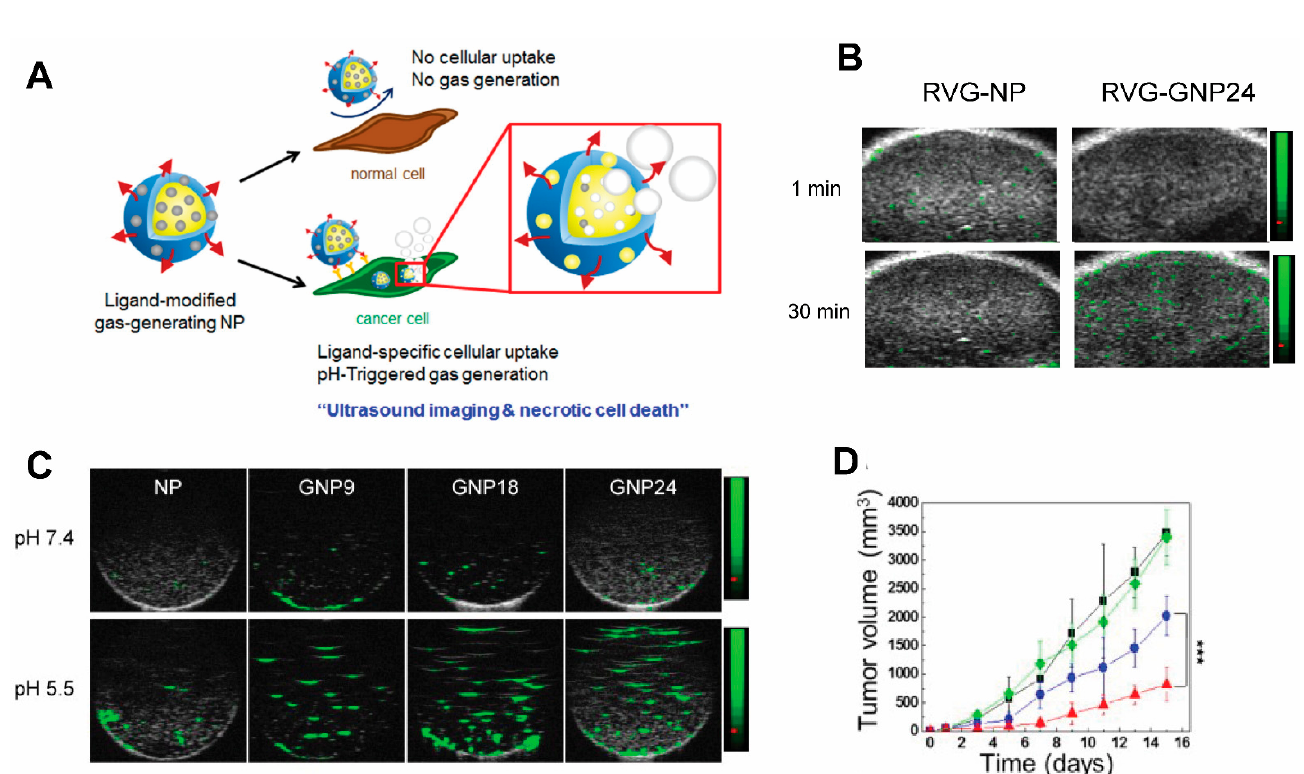
Figure 5. A targeted gas-generating nanotheranostic particle for ultrasound-guided treatment of neuroblastoma. ( A ) Schematic illustration of ligand-modified gas-generating nanoparticles for cancer-specific cellular uptake and pH-triggered gas generation. PLG nanoparticles loaded with fine-grained calcium carbonate provide theranostic functionality for cancer detection and treatment. pH change triggered carbon dioxide gas generation and these bubbles enabled simultaneous US imaging and necrosis of cancer without using conventional contrast or anti-cancer agents. ( B ) In vitro ultrasound signals of non-gas-generating NP and gas-generating nanoparticles (GNP9, GNP18, and GNP24) under neutral and acidic conditions ([GNP] = 10 mg/mL). ( C ) In vivo ultrasound imaging of tumors after intravenous injection of RVG-NP and RVG-GNP24 into a tumor-bearing mouse model (25 mg/kg, polymer/mouse at 1 and 30 min). ( D ) Changes in tumor volume of mice treated with saline (black diamond), RVG-NP (green square), RVG-GNP9 (blue circle), and RVG-GNP24 (red triangle) (10 mg/kg polymer/mouse and 20 mg/kg docetaxel/mouse; five daily intravenous injections; *** p < 0.001). Figures are adapted based on Ref. [144] with permission. Copyright 2016